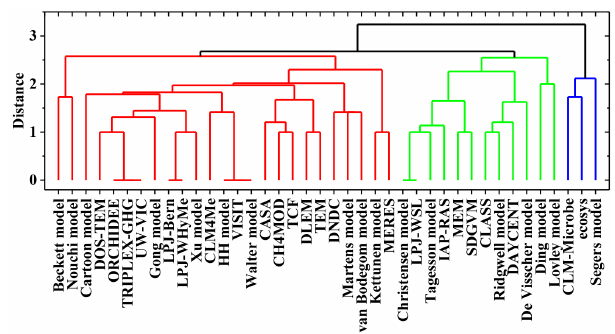
Figure 3. Cluster analysis showing three groups of CH 4 models based on model characteristics (lines with the same color indicate CH 4 models in the same group; green lines represent a relatively simple model structure, red lines represent relatively mechanistic models, and blue lines represent mechanistic models).